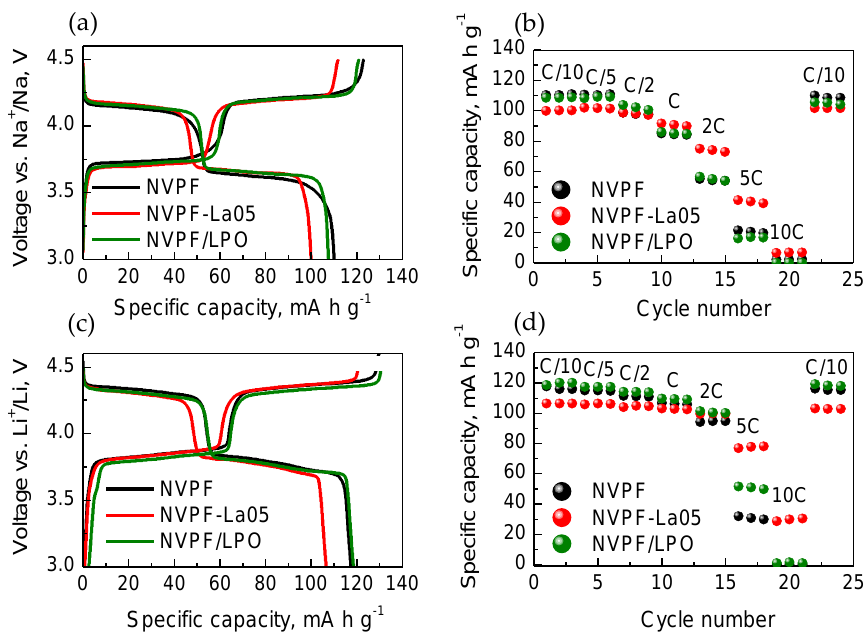
Figure 4. Second charge-discharge profiles at the C/10 rate ( a , c ) and discharge capacity vs. cycling rate (C/10–10C) plots ( b , d ) of NVPF, NVPF-La05 and NVPF/LPO upon cycling within the 3.0–4.5 V range in Na ( a , b ) and Li ( c , d ) cells.